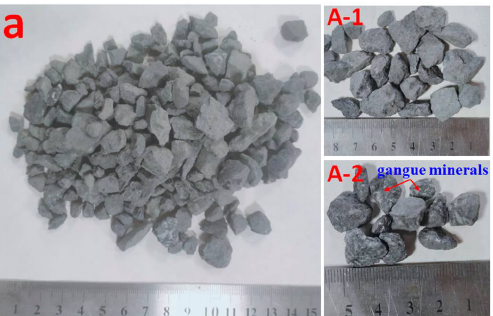
Figure 3. ( a ) Appearance of the large-grained VTM with a particle size >4.75 mm, including samples with color uniformity ( A-1 ) and light-colored ( A-2 ).